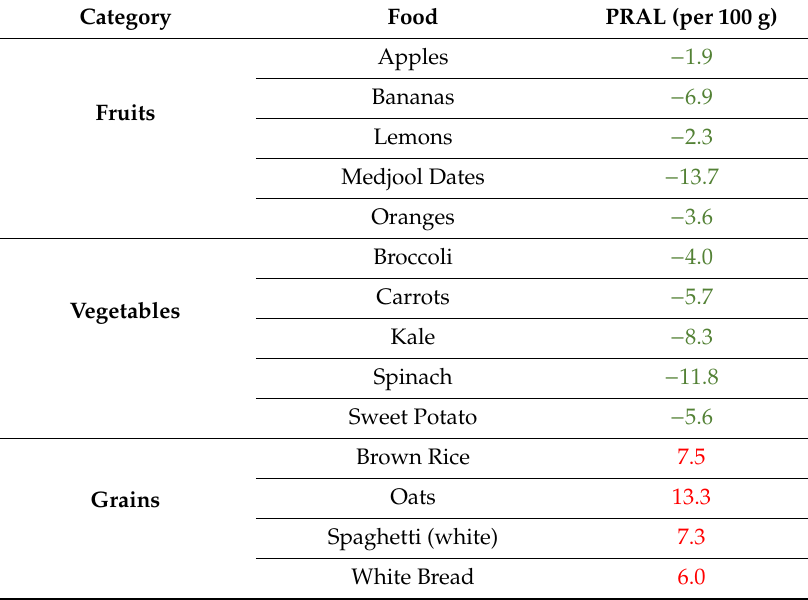
Table 2. Common foods and their potential renal acid load (PRAL) values. Each score is calculated based on a 100 g portion. Positive PRAL values (red) indicate acid-containing foods whereas negative PRAL values (green) indicate alkaline foods. Table adapted